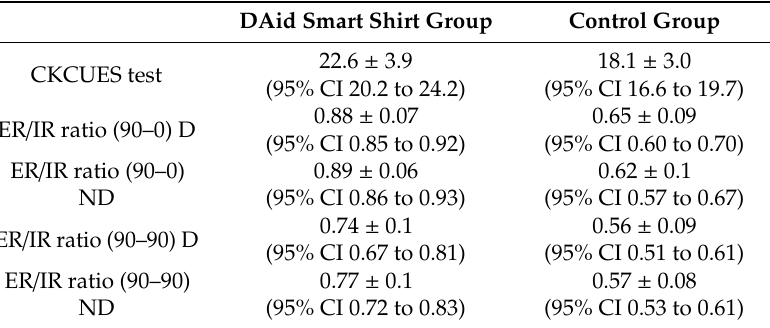
Table 3. Shoulder functional test post-treatment results (mean SD, and CI) for Closed Kinetic Chain Upper Extremity Stability (CKCUES) test and internal / external (ER / IR) rotation ratio of the dominant (D) and non-dominant (ND)